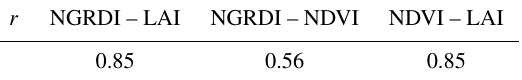
Table 2. Correlation coefficients ( r ) between LAI and NGRDI, LAI and NDVI, and NDVI and NGRDI. The correlation between NDVI and NGRDI was based on 1300 measurements, while the correla- tions with LAI were based on 6 measurements. NDVI was interpo- lated using the natural neighbor technique.